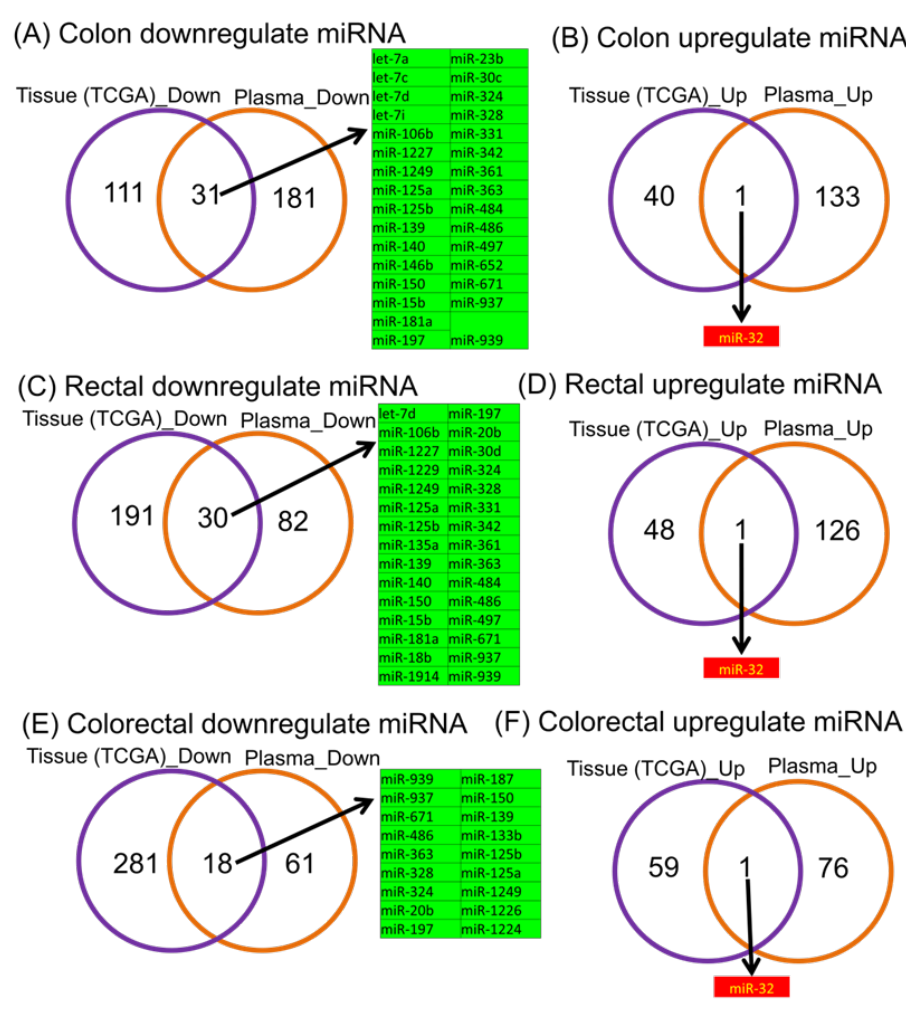
Figure 2. Common miRNA expression profile pattern in TCGA (tumor versus normal tissue) and plasma (tumor samples versus healthy controls) data on colon, rectal and colorectal cancer. The diagrams present the overlapping TCGA and plasma miRNA signatures in the case of upregulated ( A ) and downregulated transcripts ( B ) for the case of colon cancer, similarly for the case of downregulated ( C ) and overexpressed miRNAs ( D ). We also present the overlapping of the downregulated ( E ) and overexpressed miRNAs ( F ) transcripts for colon, rectal and colorectal cancer. 3.3. Plasma miRNA Pattern Affected by Chemotherapy.